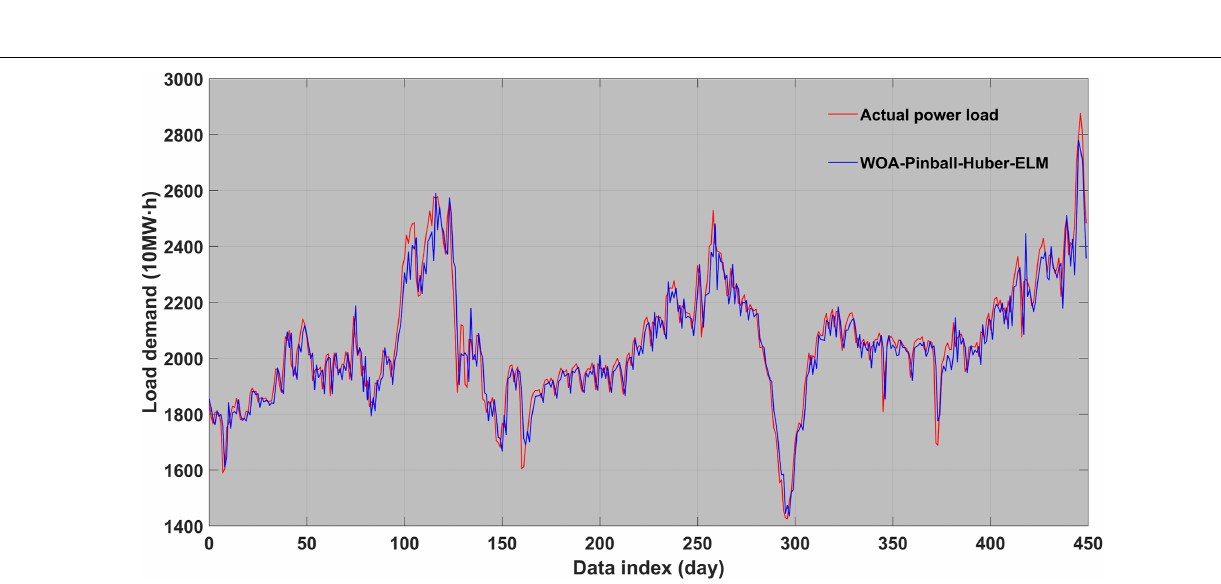
FIGURE 2 | Actual power and prediction result graph based on WOA–Pinball–Huber–ELM in